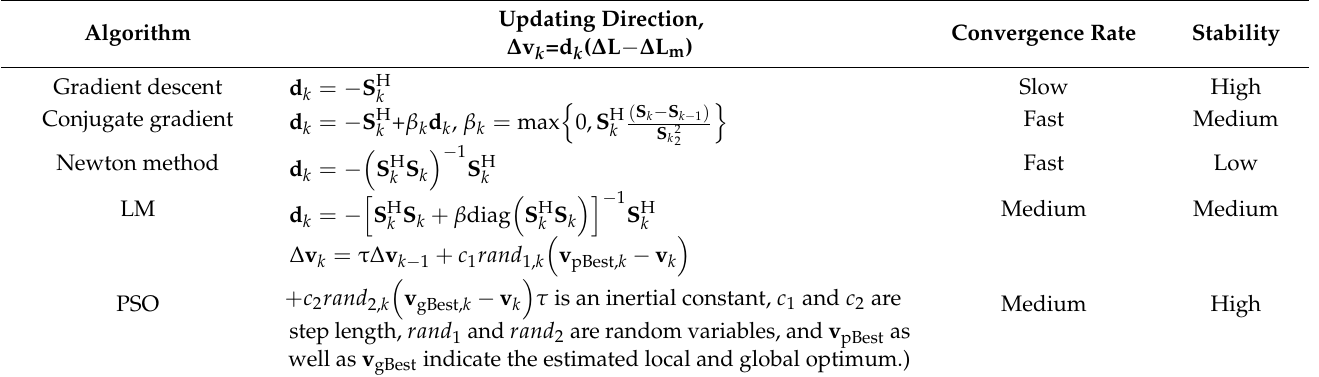
Table 3. Characteristics of nonlinear optimization